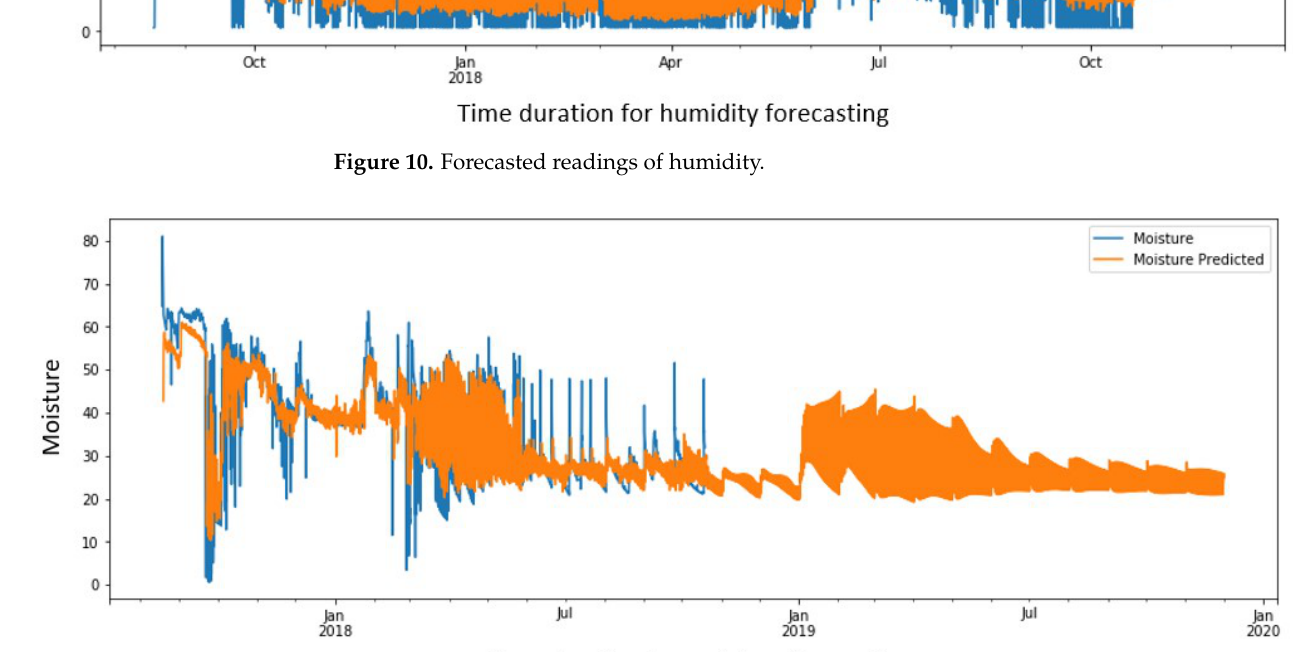
Figure 11. Forecasted readings of